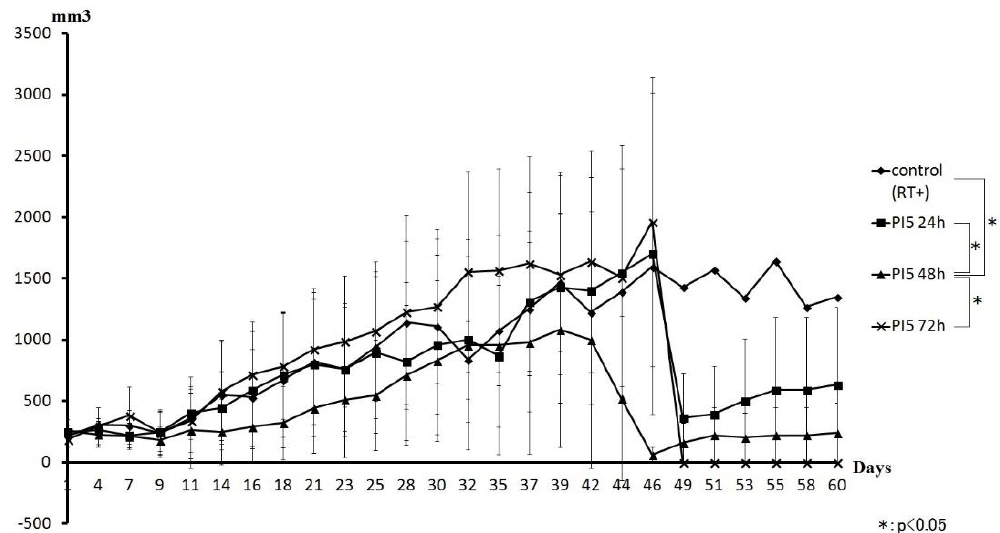
Figure 5. Comparison of the tumor volume curve between the PI5 and control groups. An inhibitory effect was seen in the group irradiated after 48 h. Abrupt decreases in tumor volume were identified on days 46 and 49. During the observation period, complete resolution of tumors occurred in the PI5 group.